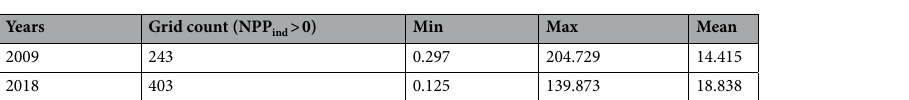
Table 5. Descriptive statistics of NPP ind in Kunming. NPP ind is the indirect impact of NPP. Grid count is the number of grid points where NPP ind > 0. The unit of max, min and mean is gC m −2 year −1 .